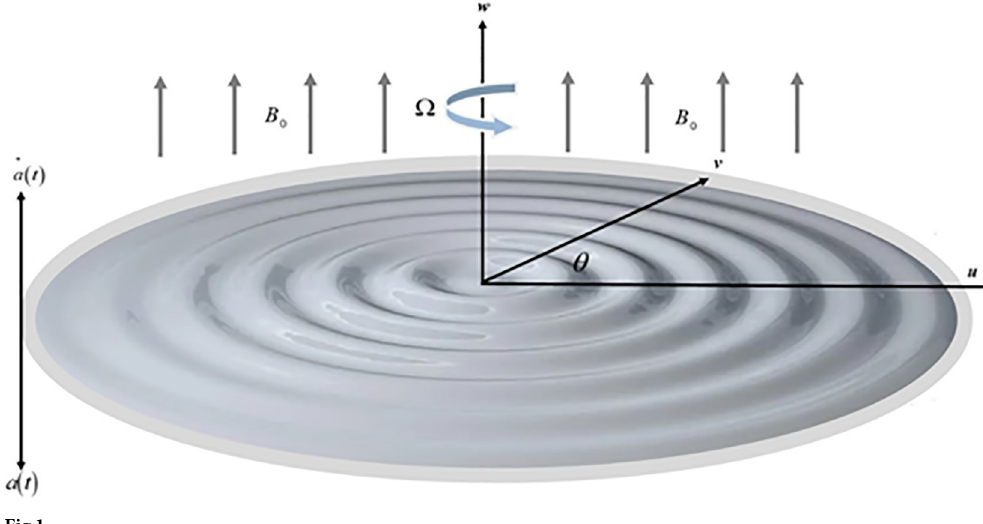
https://doi.org/10.1371/journal.pone.0254457.g001 It’s reasonable to assume that improvement rate of disk rotation significantly encourages the kinematic energy of the fluid ions, that leads to an increase in velocity g ( η ), which also gen- erates heat. The disc surface eventually heats up and improves the fluid temperature θ ( η ). Fig 9 revealed that the effect of parameter γ reduces the temperature profile. Because the fluid parti- cle releases thermal energy during upward/downward movement, which causes the declina- tion of fluid temperature. The rotating disk’s upward and downward velocity is regulated by the parameter γ .